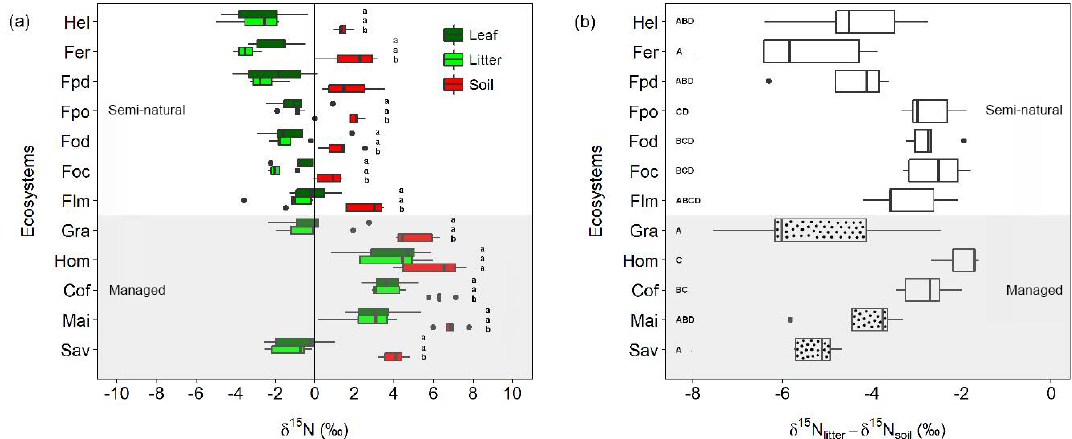
Figure 4. Variation in δ 15 N values and δ 15 N-based enrichment factors along the Kilimanjaro elevational and land-use gradient. (a) Variation in δ 15 N values for leaves, litter, and soil material sampled along the Kilimanjaro elevational and land-use gradient. Box plots show median values per ecosystem with whiskers representing the first and third quartiles. Dots represent outliers. Ecosystem data represent the average values of five sites (one per each transect), with each site being composed of five samples. Lower-case letters show significant differences between sampled materials within each ecosystem (one-way ANOVA followed by Tukey’s HSD test as a post hoc procedure, P ≤ 0 . 05). (b) Variation in δ 15 N-based enrichment factors ( δ 15 N litter-soil ) calculated for the different ecosystems along the elevational and land-use gra- dient. Dotted box plots indicate ecosystems dominated by C 4 vegetation. Capital letters indicate significant differences between ecosystems (one-way ANOVA followed by Tukey’s HSD test as a post hoc procedure, P ≤ 0 . 05). The ecosystem acronyms used are the same as those in Table 1. Sites are ordered by increasing